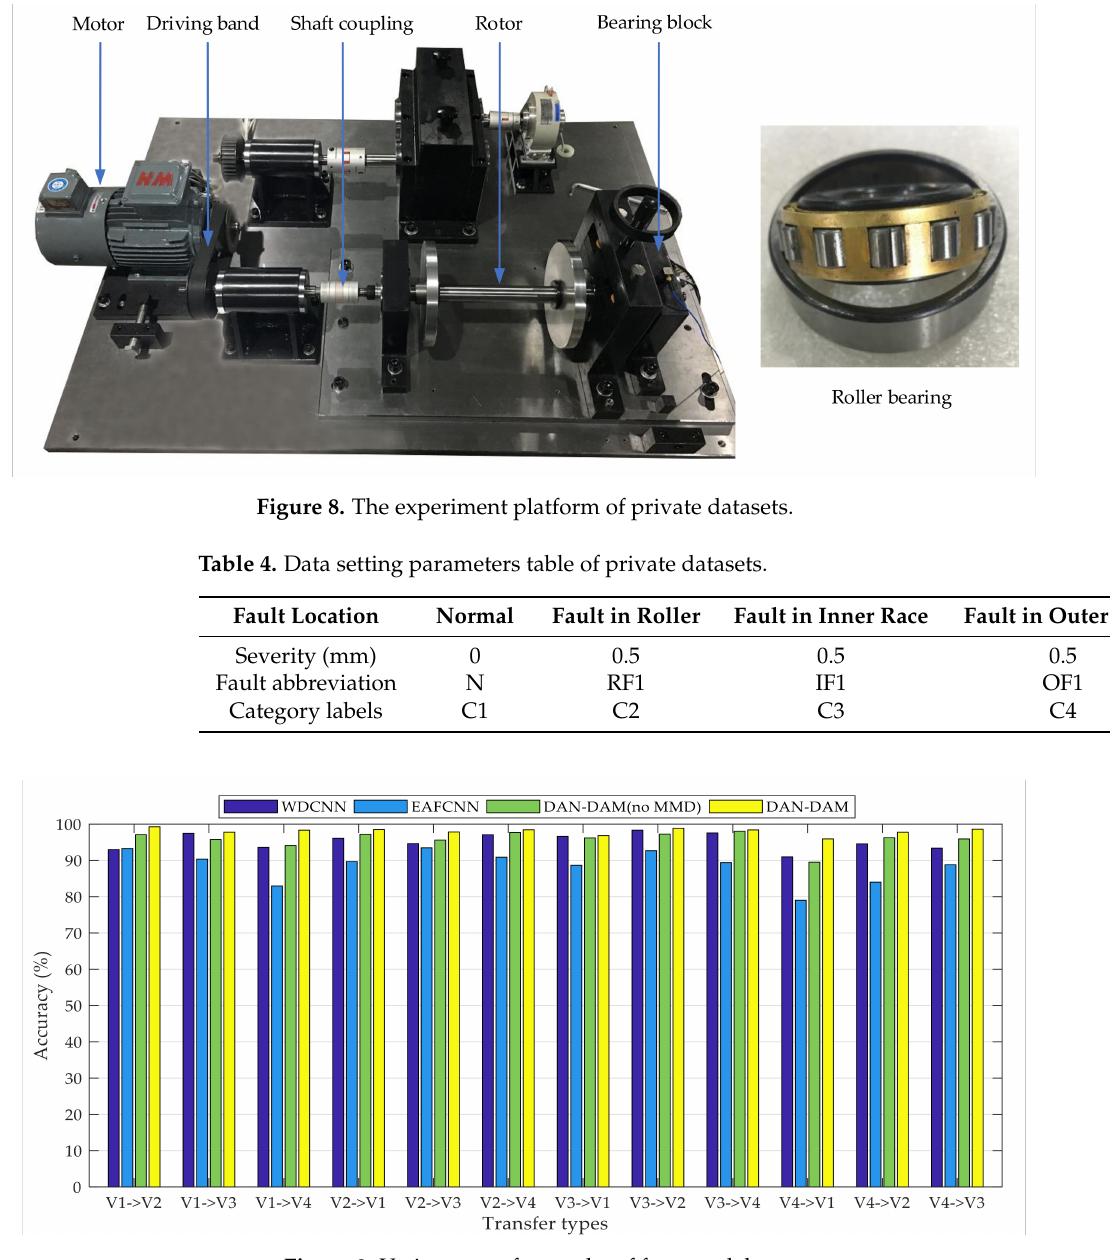
Figure 9. Various transfer results of four